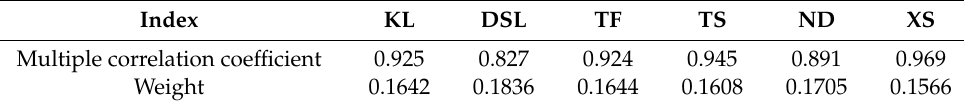
Table 8. Weight of each index based on independence weight coefficient